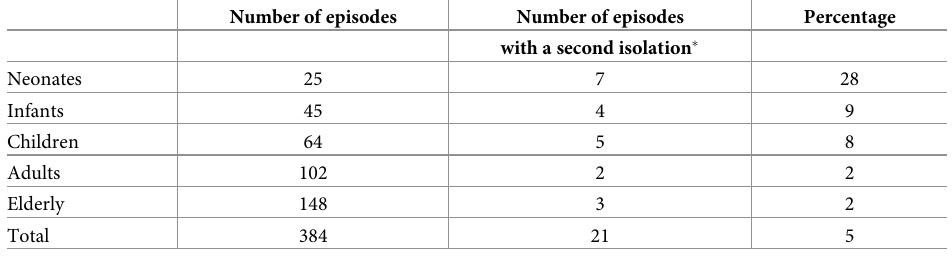
Table 2. Second isolation of Candida species after 72 hours of antifungal therapy in 384 episodes of candidemia, by age